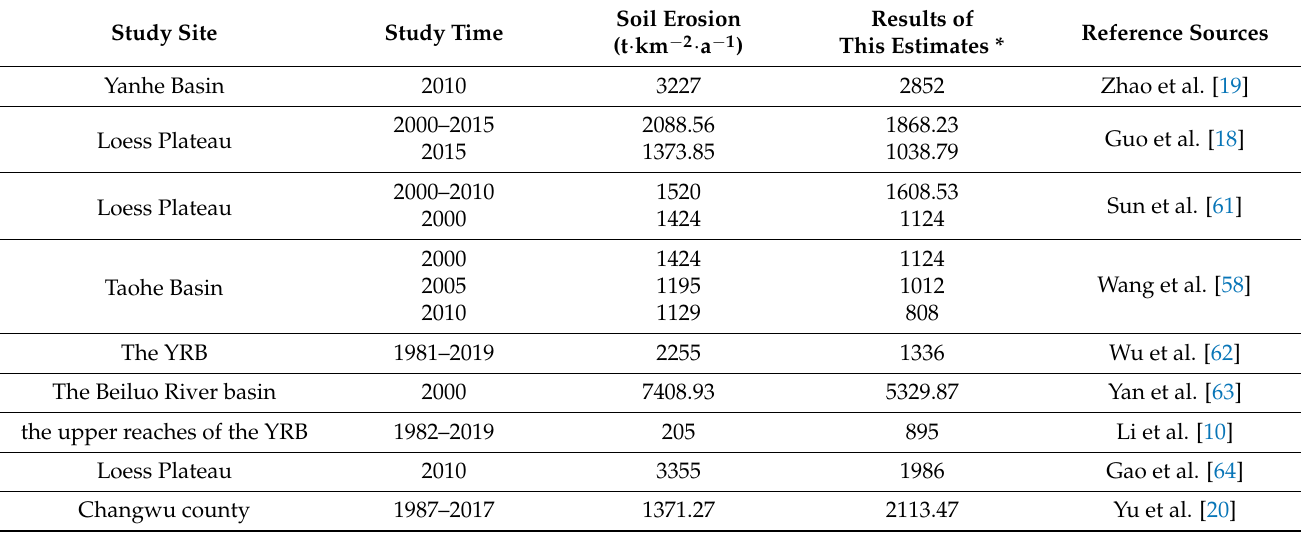
Table 2. Soil erosion modulus obtained from previous